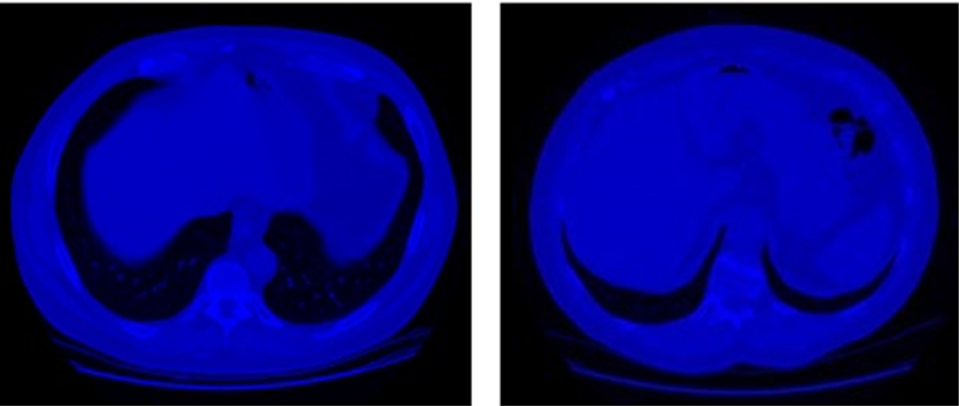
Figure 3. Example of without cancer samples ( left ) and with cancer samples ( right ) of the dataset [18].